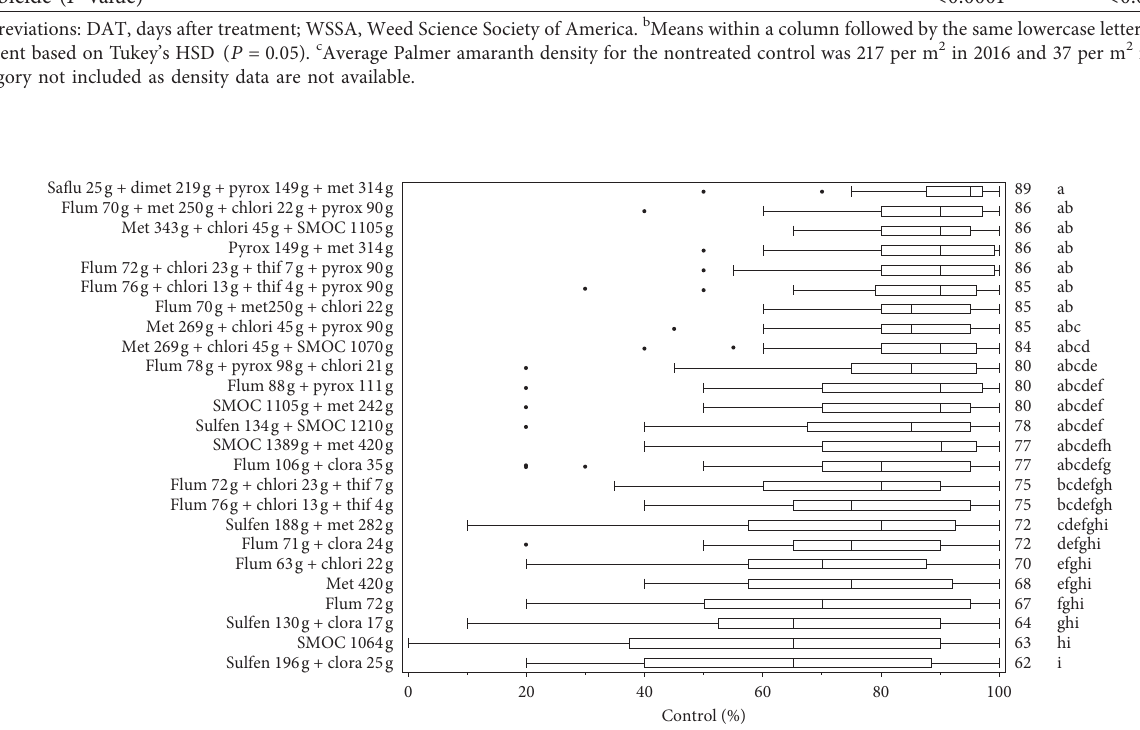
Figure 1: Box and whisker plots for Palmer amaranth control at 28 days after treatment (DAT) over locations in 2016. Statistical means and separation are shown with the corresponding treatment in descending order, derived from a Tukey’s HSD. Each treatment listed included a sample size of 32 data points. Use rates are provided to the right of each herbicide in g ai ha − 1 . Abbreviations: chlori, chlorimuron-ethyl; clora, cloransulam; dimet, dimethenamid-p; flum, flumioxazin; met, metribuzin; pyrox, pyroxasulfone; saflu, saflufenacil; SMOC, S-metolachlor; sulfen, sulfentrazone; thif,